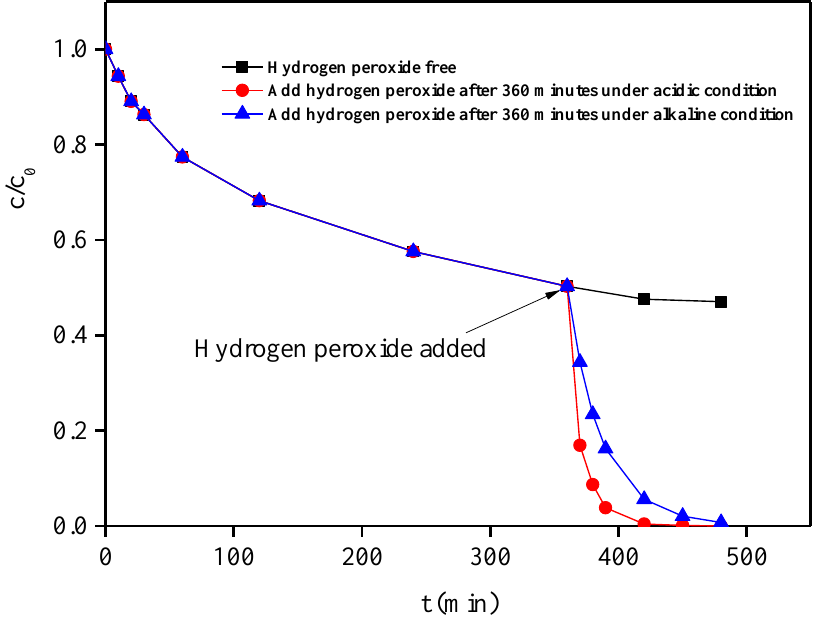
Figure 6. Concentration change of H 2 O 2 on Rhodamine B after adsorption equilibrium of granular catalyst.